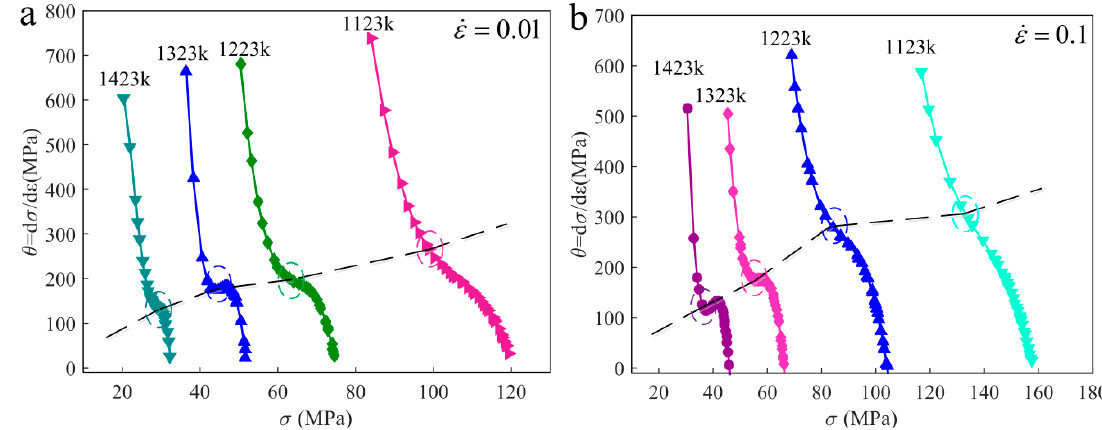
. ε = . ε = ε  ε  0.01 s − 1 ; ( b ) 0.1 s − 1 . = 0.01 s − 1 ; ( b ) = 0.1 s − 1